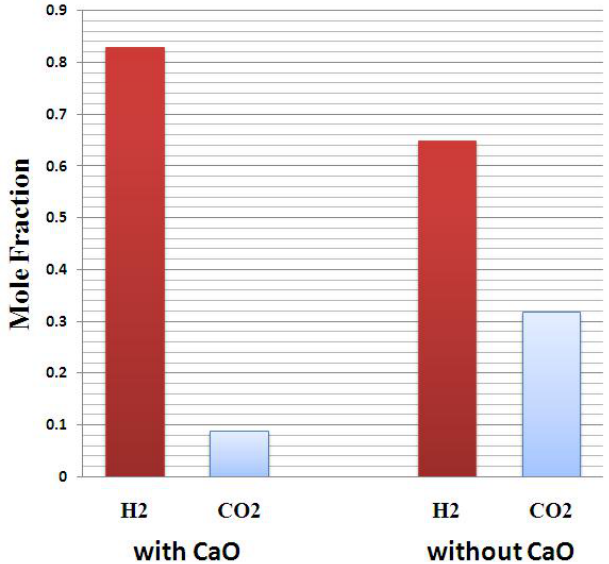
Figure 8. Effect of sorbent/biomass ratio on product gas. Biomass feed rate: 0.072 kg/h; Temperature: 950 K; Steam/biomass ratio: 3.5. H